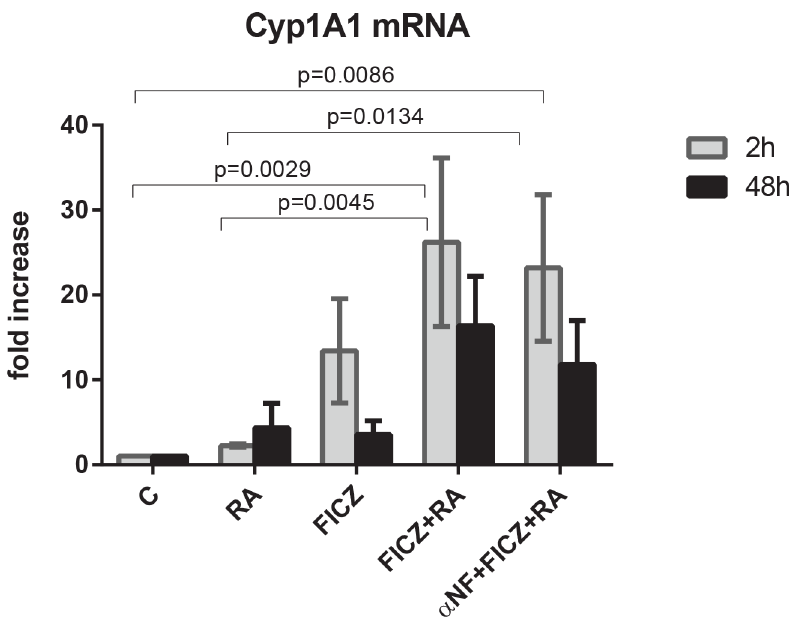
Fig 4. FICZ upregulates Cyp1A1 expression. HL-60 cells were initiated in culture at 0.1 x 10 6 cells/ml with 1 μ M RA, 100 nM FICZ, 1 μ M α -NF as indicated for 2 h and 48 h. At 2 h post treatment, FICZ upregulates Cyp1A1 expression in HL-60 cells, reaching significance for RA+FICZ vs C (p = 0.0029) and vs RA (p = 0.0045) and α -NF+FICZ+RA vs C (p = 0.0086) and vs RA (p = 0.0134).